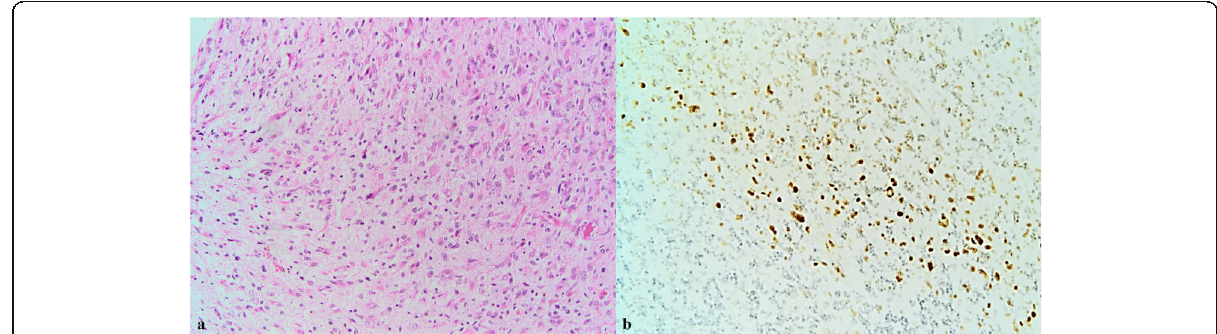
Fig. 2 a Tumour cells dispersed in the normal brain (HE 20X). b Immunohistochemical expression for p-Stat3Y705 at the tumour invasion front. We can evidence an increased intensity of expression where the tumour invades the normal brain tissue